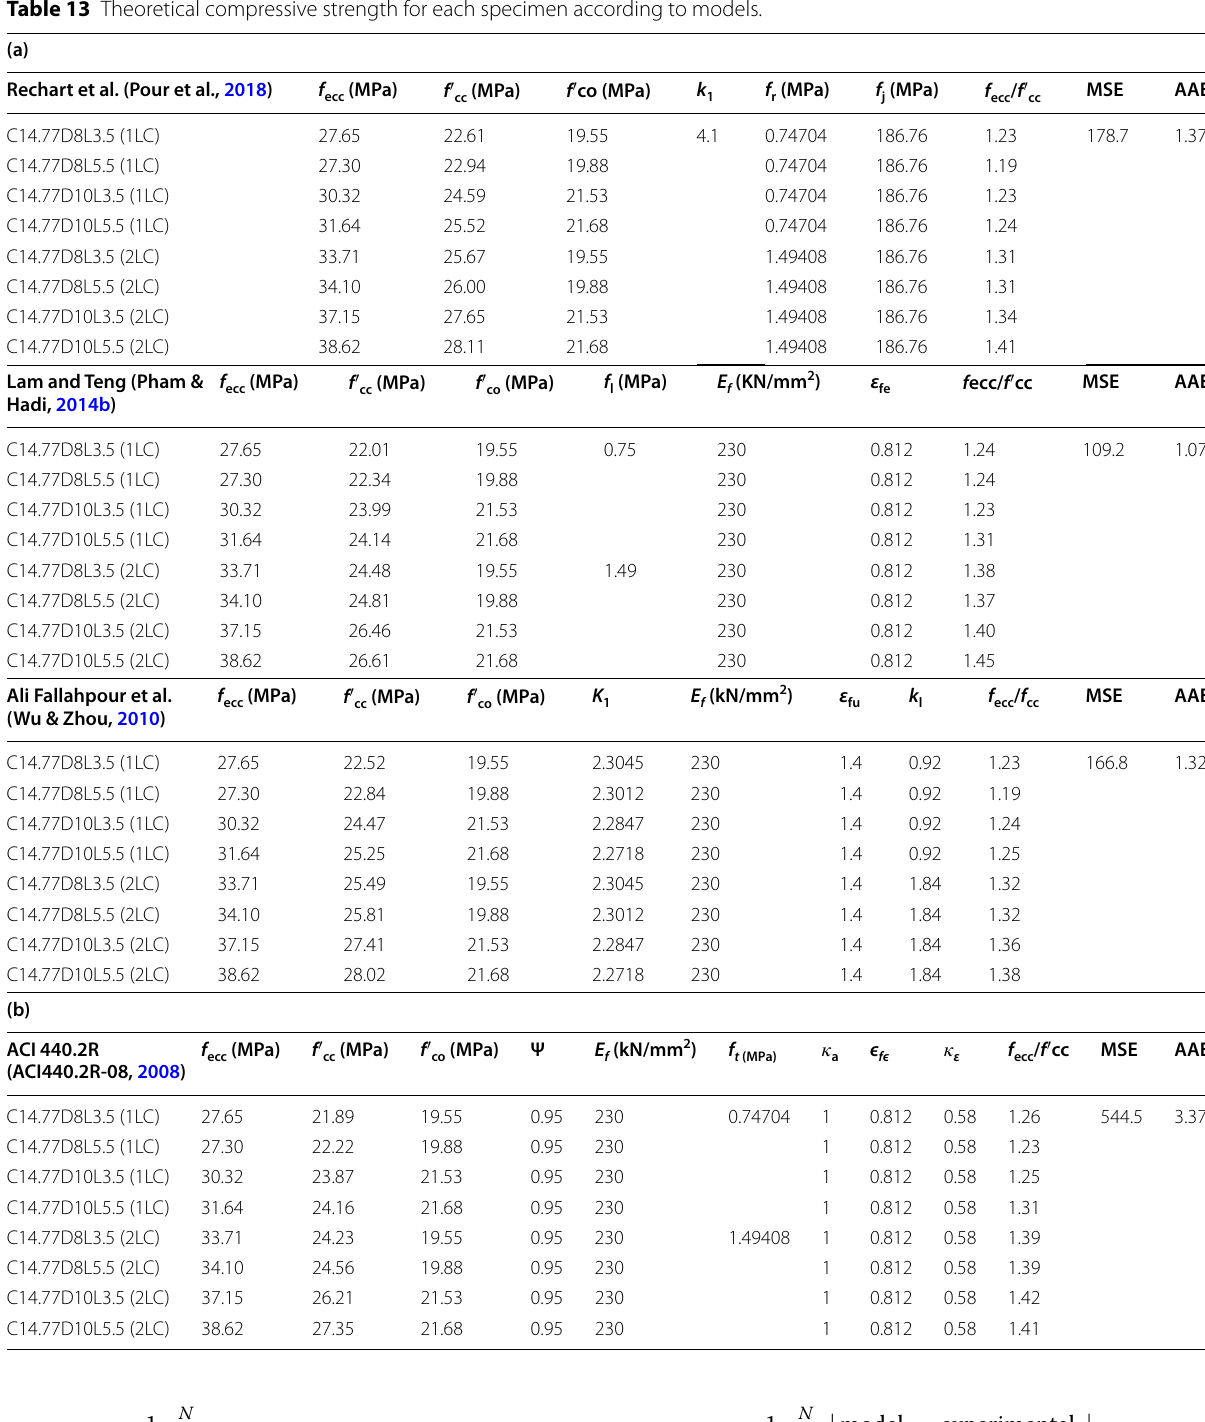
Table 13 Theoretical compressive strength for each specimen according to models. (a) Rechart et al. (Pour et al.,